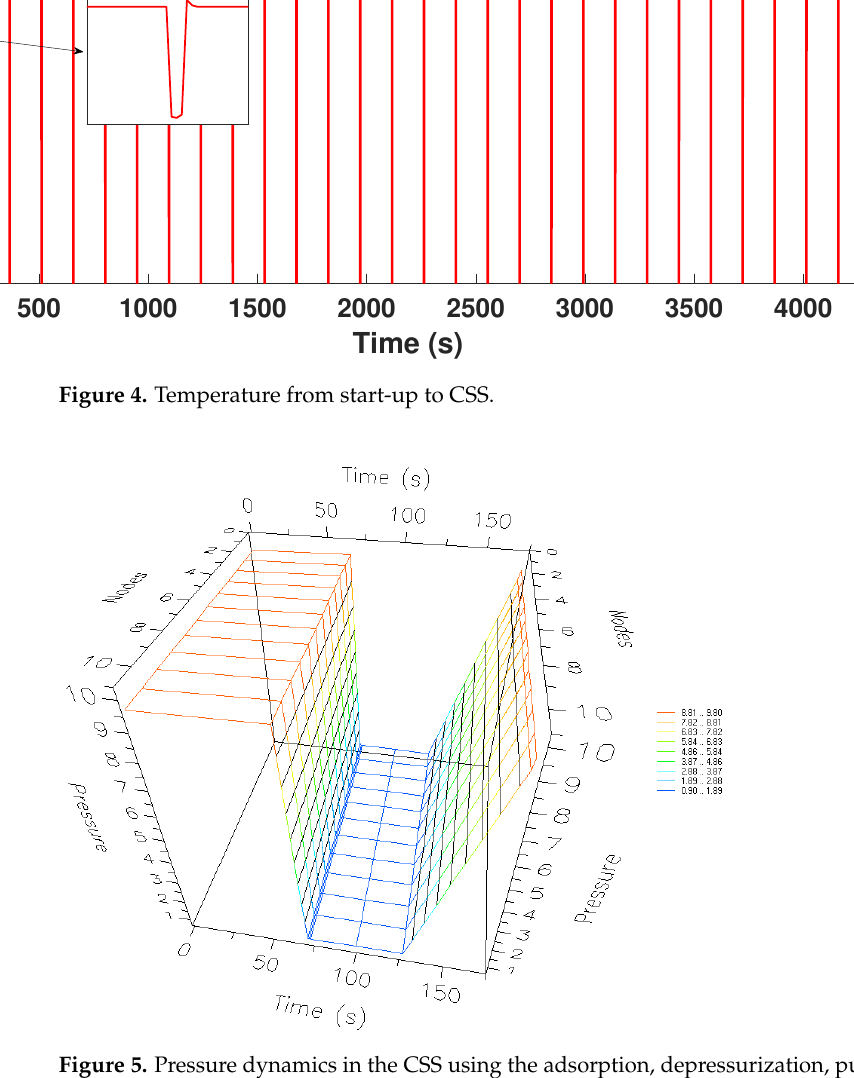
Figure 5. Pressure dynamics in the CSS using the adsorption, depressurization, purge, and repressur- ization